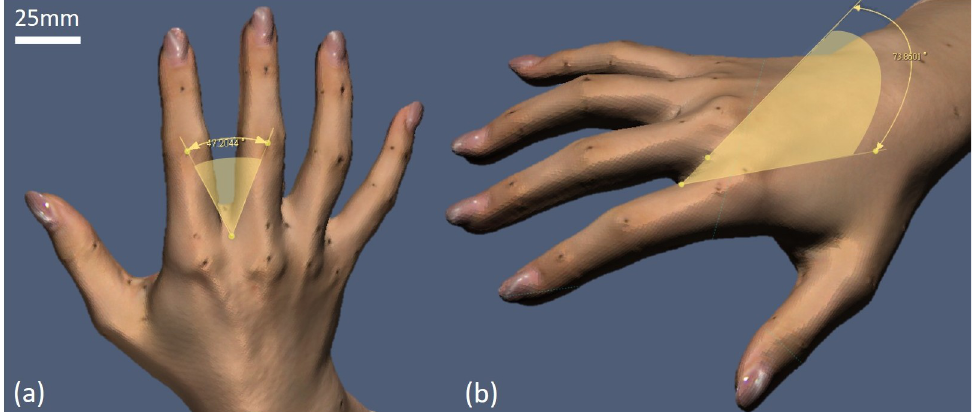
Fig 3. (a) Web space angle between D2 and D3, and (b) slant of web space between D2 and D3 measured in Rapidform XOR 3D scanning